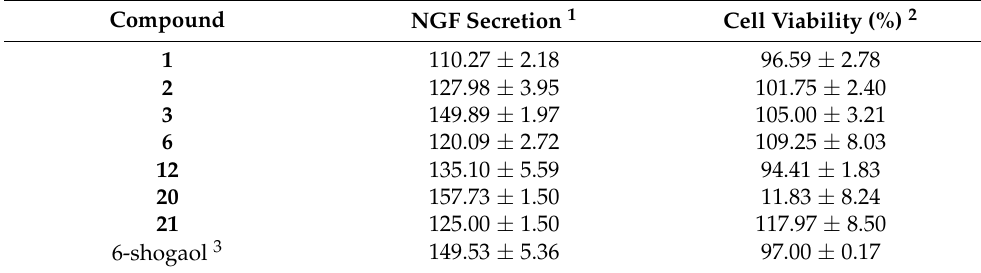
Table 4. Effects of selected compounds on nerve growth factor (NGF) secretion in C6